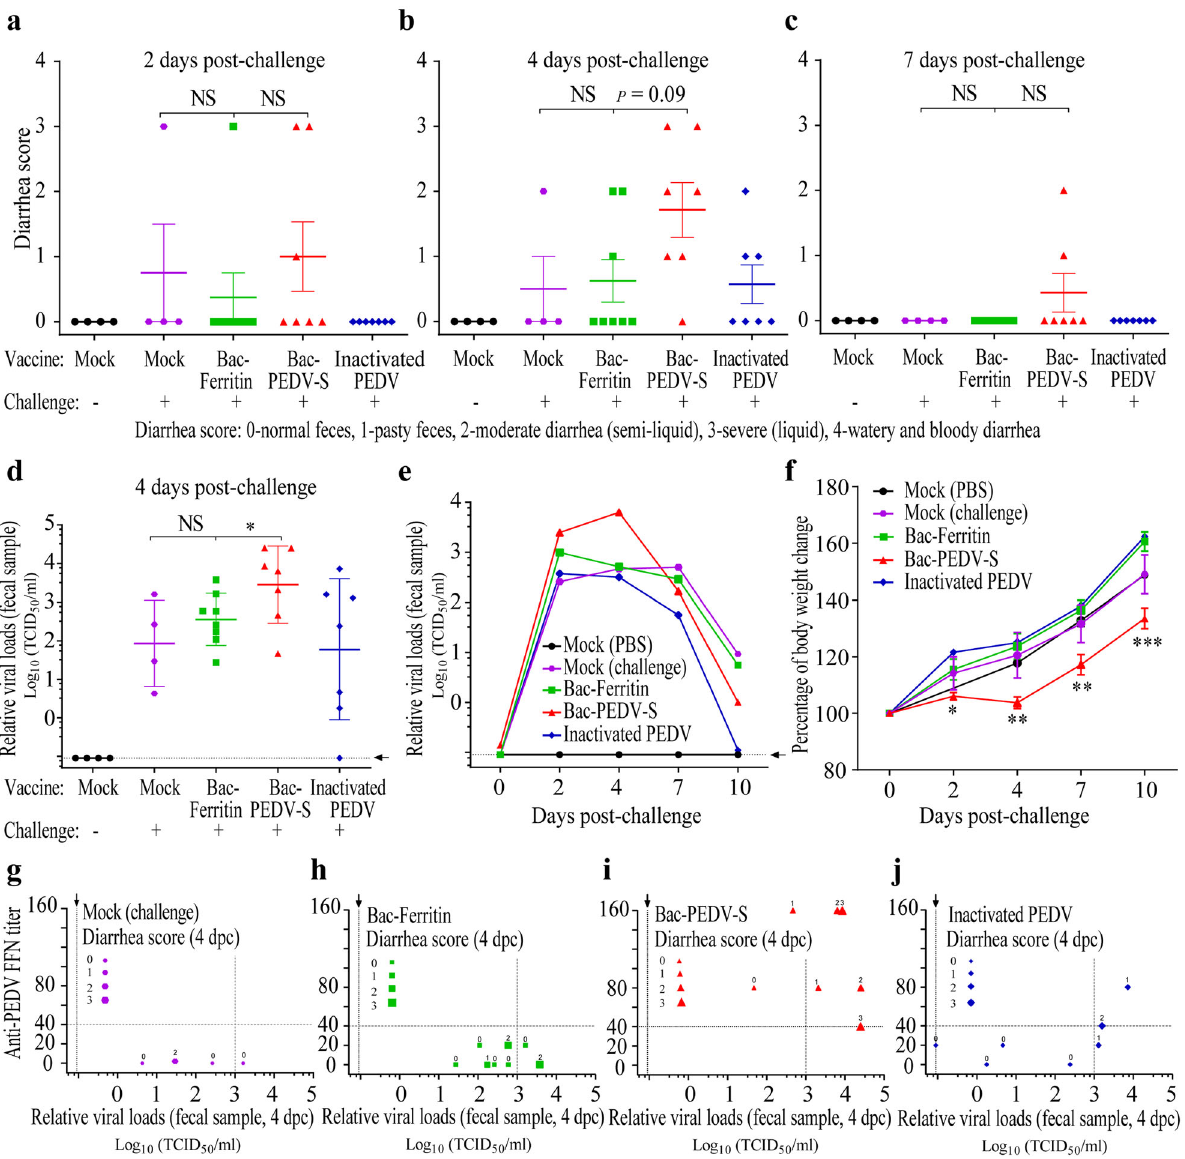
Fig. 2 Bac-PEDV-S vaccine group exhibited enhanced clinical symptoms and virus replication. a – c Fecal consistency was scored at indicated time points for each group. d , e PEDV shedding in feces was tested by RT-qPCR and reported as the relative viral loads determined by the standard curve. f The averaged body weight gain of piglets on indicated days post-challenge in each group was calculated by comparison with body weight of animals on the day of the challenge. g – j The neutralizing antibody titers, relative viral loads, and diarrhea scores were plotted together for individual piglets in different vaccination groups. The meaning of error bars and marked signs were described in the “ Methods ”